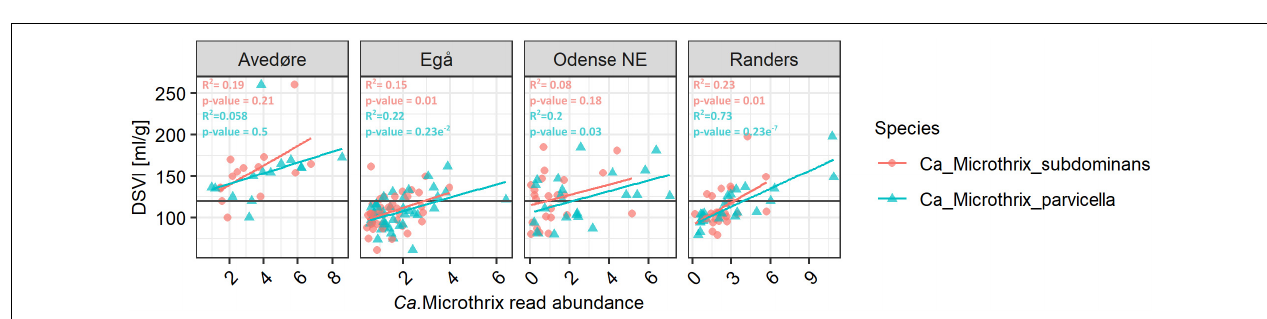
FIGURE 3 | Relationship between Ca. Microthrix species abundance and DSVI in chosen full-scale Danish nutrient removal plants. The Danish data subset containing 128 samples from 4 WWTPs sampled in the period 2006–2018 (Nierychlo et al., 2020a) was used. Values above the line of 120 ml/gSS for DSVI represent sludge with poor settling properties. To determine the statistical support of Ca. Microthrix species abundance relationship with DSVI, ANOVA test was